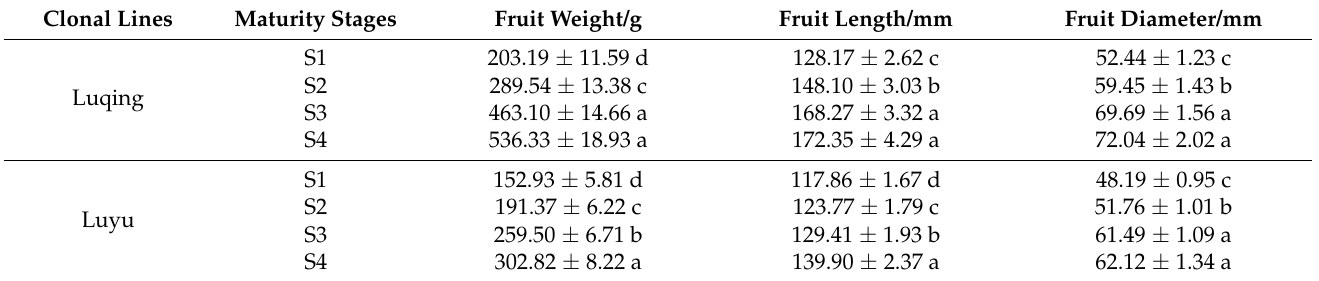
Table 1. Effect of harvest maturity on physical parameters of two Akebia trifoliata clonal lines ‘Luqing’ and ‘Luyu’